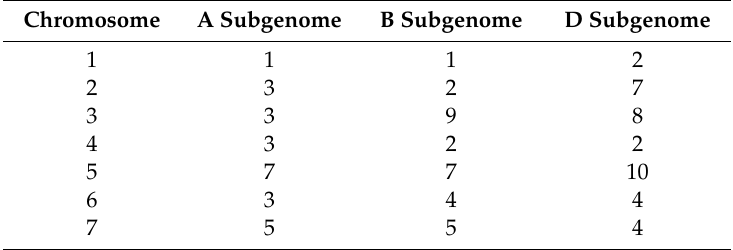
Figure 1. Chromosomal repartition of the 92 TaSKP1-like genes on the 21 chromosomes of the wheat genome (A, B and D subgenomes). Colors indicate genes belonging to the same structural class (see Table S1). Red arrows indicate the genes considered for duplication analysis (see Table S4). Table 1. The distribution of 92 TaSKP1-like genes (International Wheat Genome Sequencing Consortium (IWGSC) RefSeq) in T. aestivum 21